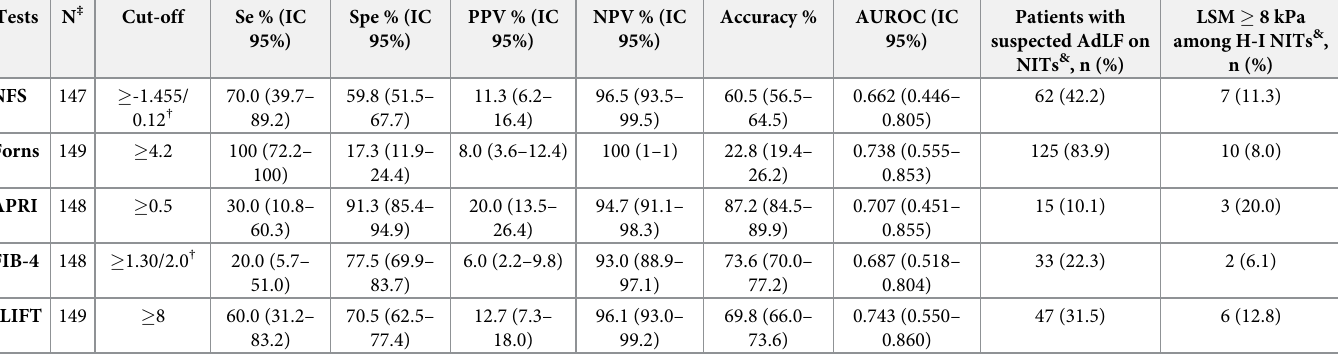
Table 4. Screening for advanced liver fibrosis (LSM � 8.0 kPa) using non-invasive fibrosis tests in the “at risk” subgroup of NAFLD with a valid